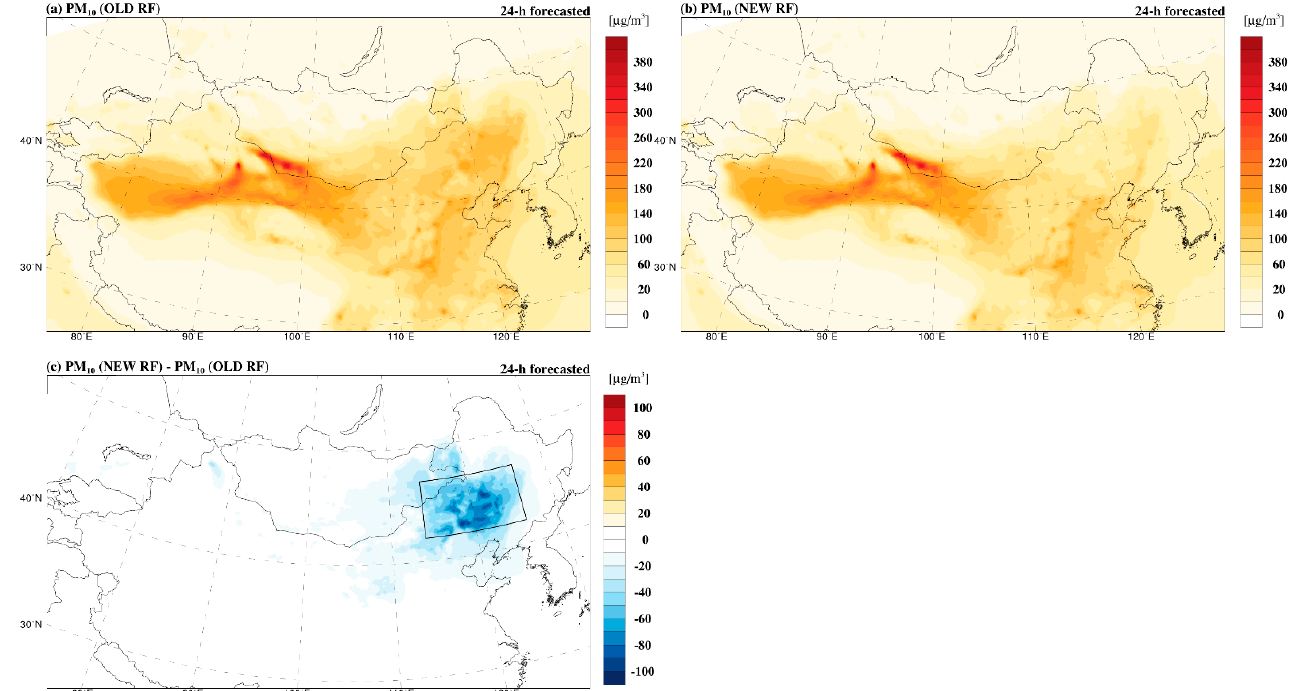
Figure 3. Spatial distribution of ( a ) PM 10 (OLD_RF) and ( b ) PM 10 (NEW_RF), which are 6 h averaged PM 10 mass concentrations at the 24 h valid time forecasted by the OLD_RF and NEW_RF runs, respectively, averaged during spring (March to May) 2017. ( c ) PM 10 difference between PM 10 (NEW_RF) and PM 10 (OLD_RF).